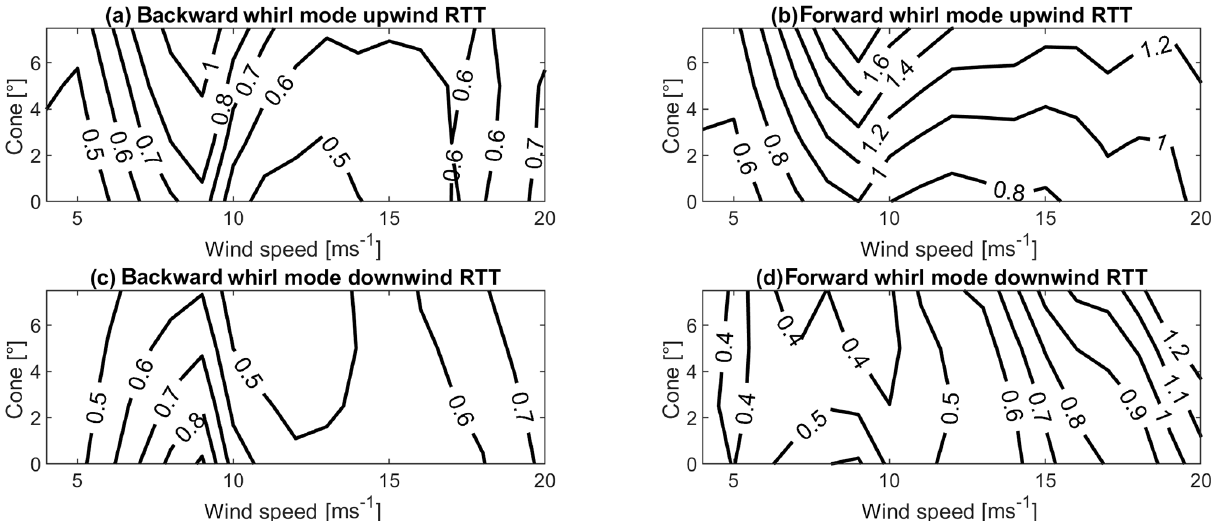
Figure 7. Normalized edgewise whirl damping as a function of wind speeds and cone angle for the backward whirl mode (a, c) and the forward whirl mode (b, d) , for the upwind RTT configuration (a, b) and the downwind RTT configuration (c, d) . The whirl damping is normalized with the damping value of forward whirl mode in the upwind configuration at 0 ◦ at 9ms − 1